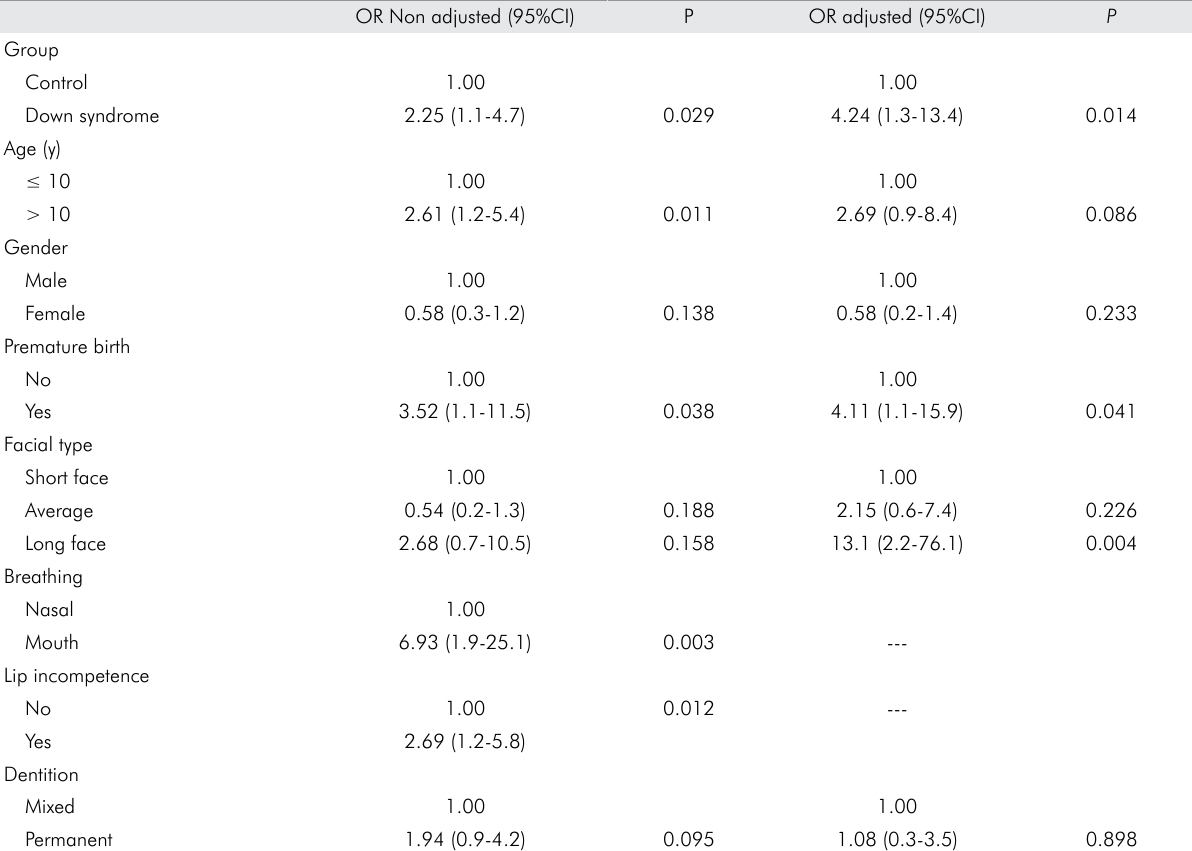
Table 3. Univariate and multivariate logistic regression analyses considering associations between malocclusion severity and independent